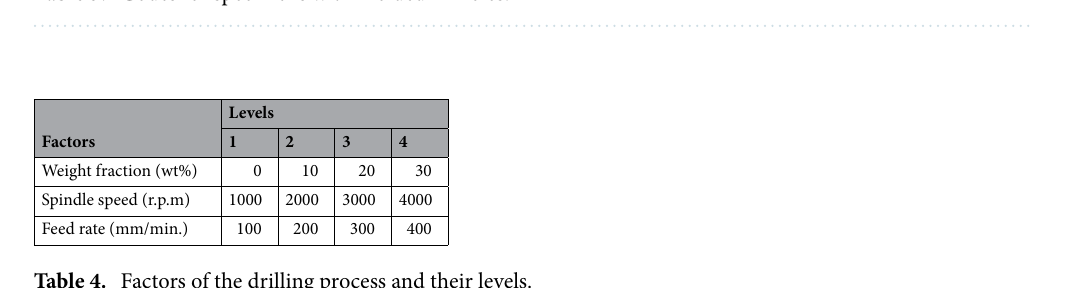
Table 3. Codes for specimens with molded-in holes.